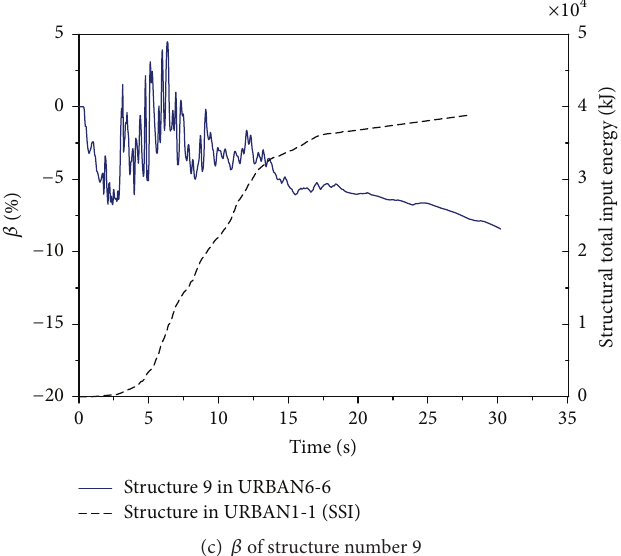
Figure 31: Interaction between structures in terms of influence coefficient 𝛽 (URBAN6-6, 𝐷 = 0.5 , V 𝑠 = 0.5 V 𝑠 , MCH000, 𝑆𝑋 ). The solid lines are the influence coefficient 𝛽 of structures in URBAN6-6. The dashed line is the structural total absorbed energy in the URBAN1-1 (SSI)